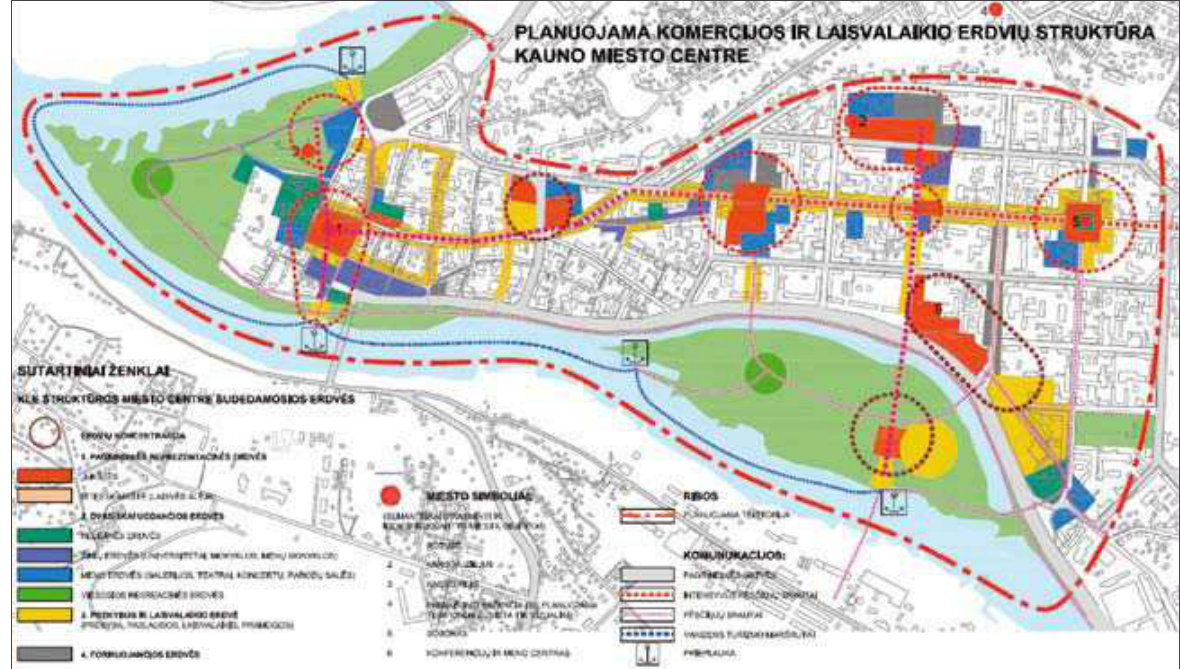
Fig. 4. Proposed structure of commercial and leisure spaces in kaunas city center (by A. Gabrys